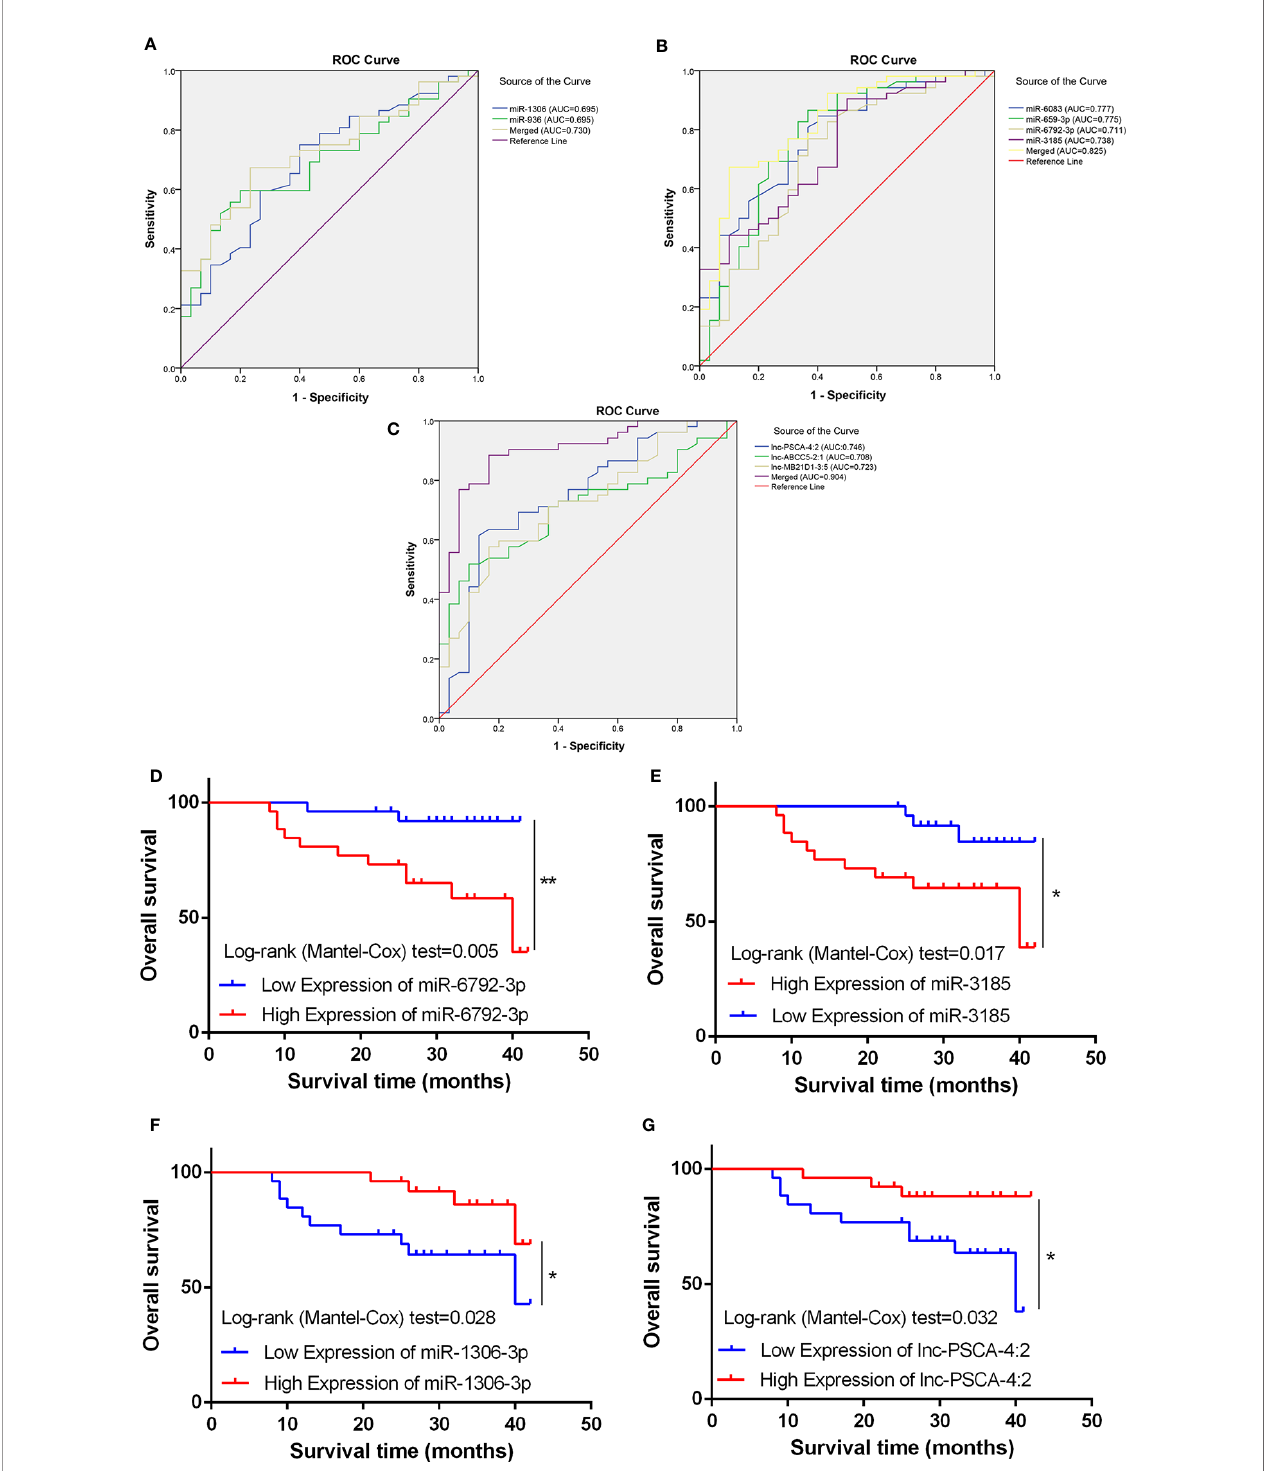
FIGURE 5 | Diagnostic potential of miRNA and lncRNA. (A) The area under the ROC curve (AUC) value of miRNA-936 and miRNA-1306-3p was 0.675 and 0.658 respectively. (B) The AUC value of miRNA-3185, miRNA-6083, miRNA-659-3p and miRNA-6792-3p was 0.775, 0.739, 0.777 and 0.711 respectively. (C) The AUC value of lnc-PSCA-4:2, lnc-ABCC5-2:1 and lnc-MB21D1-3:5 was 0.746, 0.708, and 0.723 respectively. (D, E) Kaplan-Meier overall survival curve revealed patients with higher miR-6792-3p and miR-3185 expression showed a reduced survival time. (F, G) Kaplan-Meier overall survival curve revealed patients with lower miR- 1306-3p and lnc-PSCA-4:2 expression showed a reduced survival time. *p < 0.05, **p <